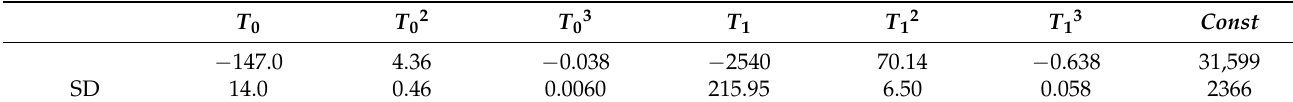
Table 5. The coefficients for Equation (15) with powers of temperatures T 0 and T 1 .